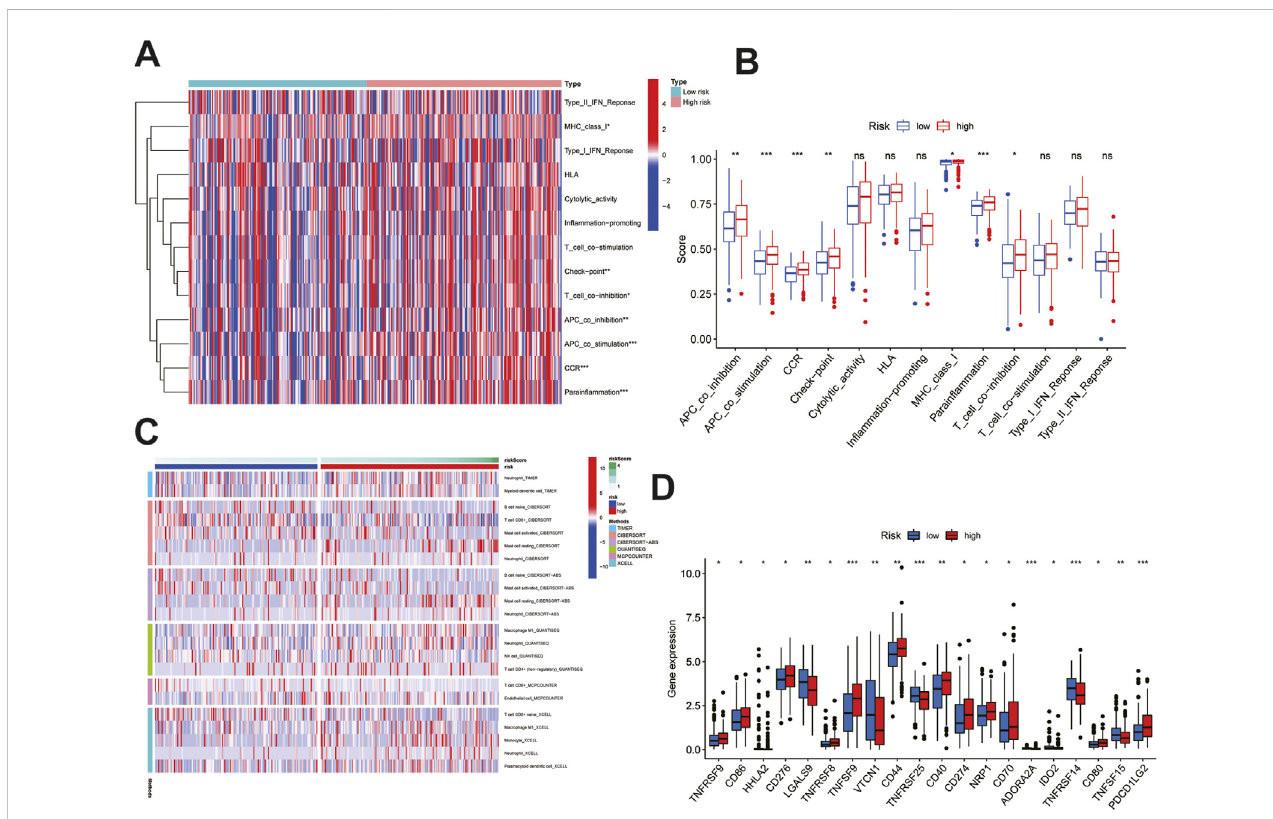
FIGURE 7 Immune in fi ltration analysis of the signature. (A) Heatmap showed immune cells and immune function between high and low risk groups in all samples. (B) Differences in immune function between high and low risk groups. (C) Heatmap of immune penetration based on TIMER, CIBERSORT, CIBERSORT-ABS, QUANTISEQ, MCPCOUNTER, and XCELL algorithms. (D) Differences in immune checkpoints between high-and low-risk groups. Data are shown as means ± S.D. ns: not signi fi cant, * p < 0.05, ** p < 0.01, *** p <